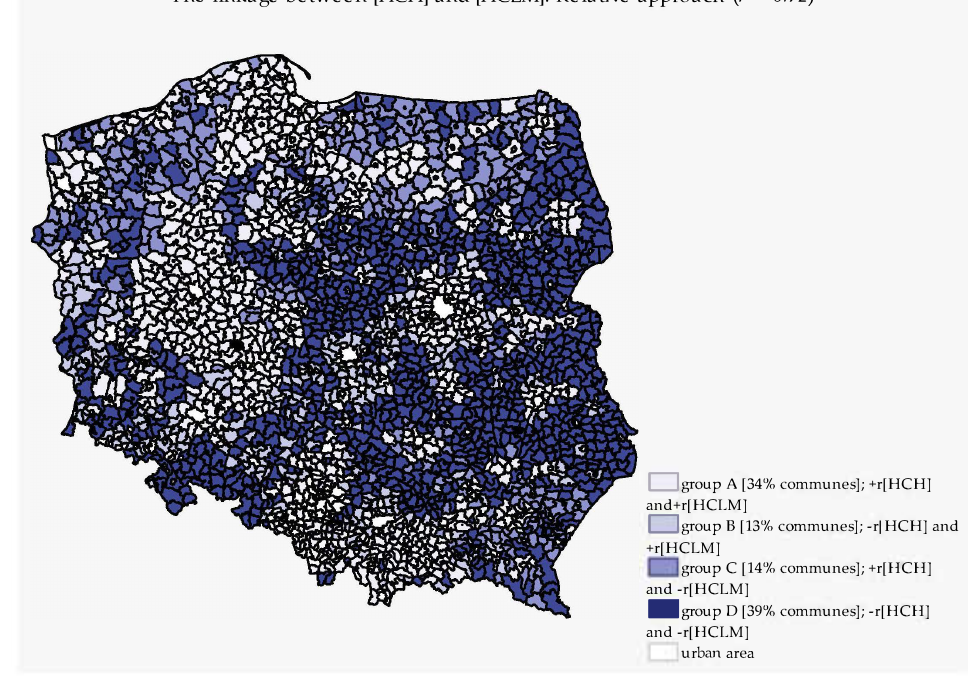
Figure 6. Linkage between human capital in the area of health [HCH] and the labor market [HCLM]. Source: own elaboration. Table 6. Structure of communes in terms of the level of the measure [S-EDI] and individual compo- nents of human capital [HCH] and [HCLM] (in %). Pearson correlation. [S-EDI] rel. [HCLM] [HCH] [S-EDI] rel. 1.000 [HCLM] 0.766